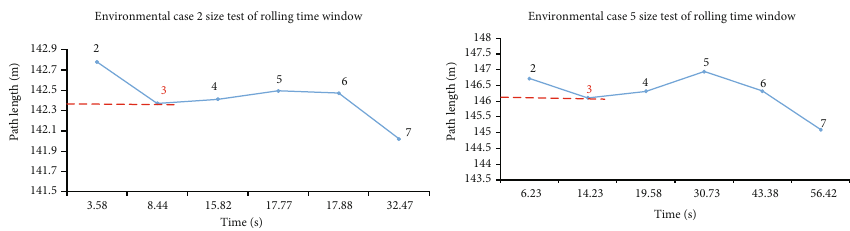
Figure 11: In fl uence of the rolling time window T